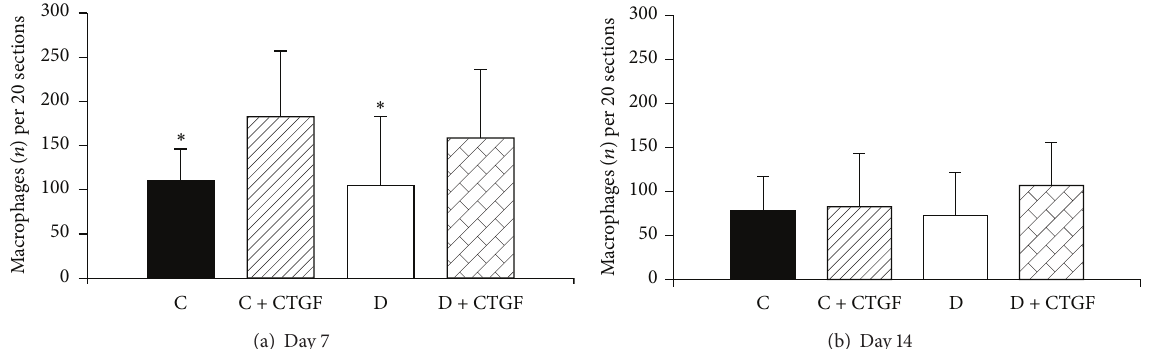
Figure 1: Wound macrophage counts. (a) CTGF treated (control and diabetic groups combined) is different to CTGF untreated (control and diabetic groups combined); ∗ 𝑃 < 0.05 by unpaired 𝑡 -test at day 7. No statistical difference was observed between groups at day 14 (b). Results are expressed as mean ± SEM.